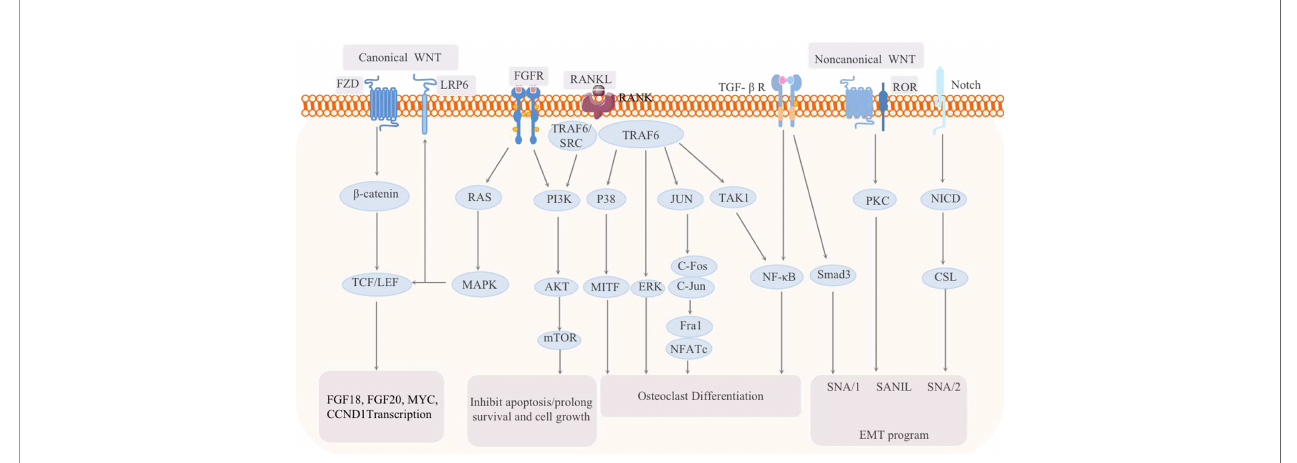
FIGURE 5 | Schematic of the signaling pathways related to breast cancer bone metastasis: the classic WNT pathway and the noncanonical WNT pathway, as well as the FGF-FGFR, RANK-RANKL, TGF, and Notch pathways, are all involved in the regulation of breast cancer bone